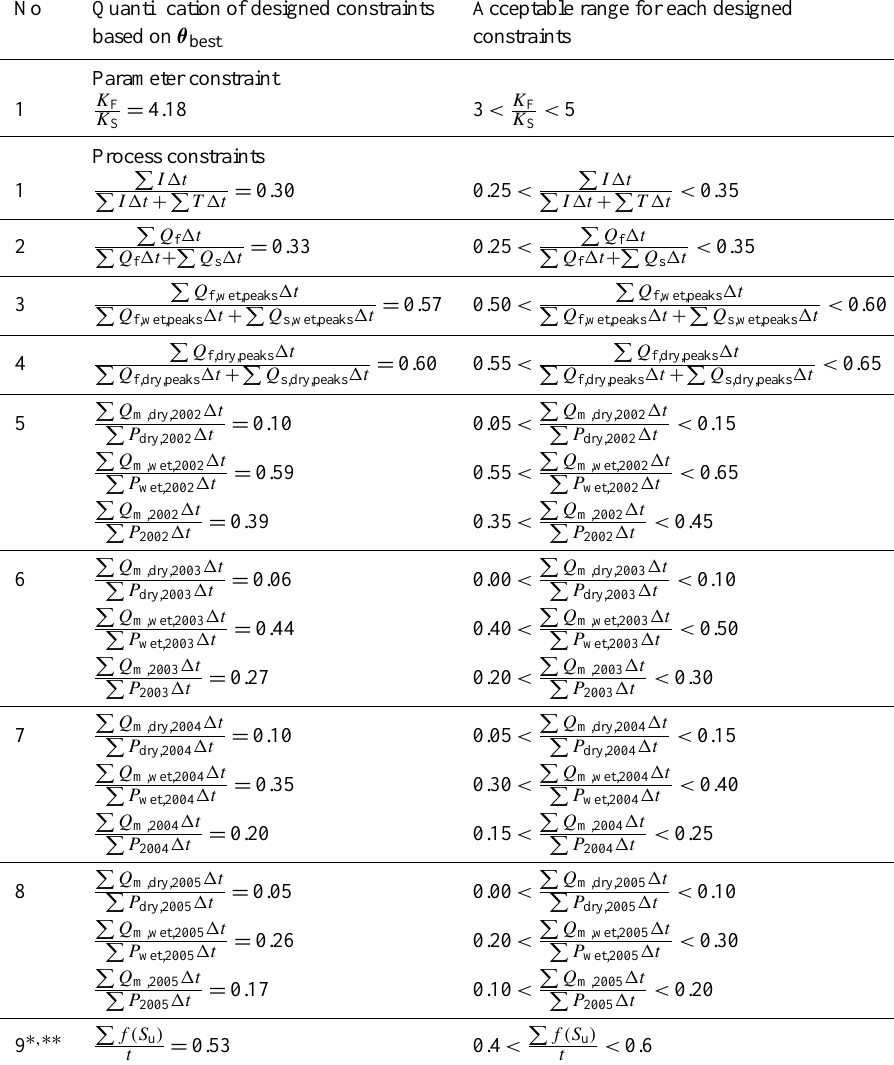
Table 1. The “true” values for each of the design constraints (corresponding to θ best .) along with the acceptable limits assigned to each constraint for use during the search. Dry and wet periods are defined as May to October and November to April respectively. Events in which the discharge increases with a rate of more than 0.2mm (3h) − 2 are defined as peak flows. No Quantification of designed constraints Acceptable range for each